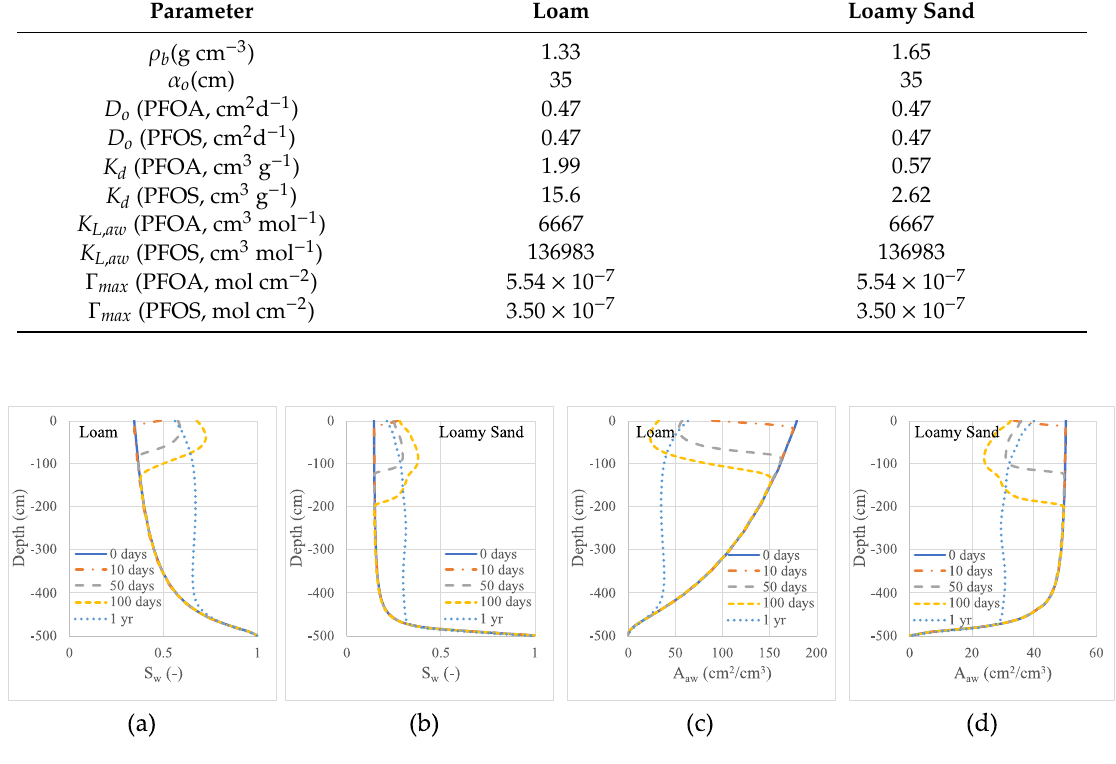
Figure 5. Illustration of the temporal changes in soil moisture and air-water interfacial area during the application of the modified HYDRUS simulator: ( a ) change in S w with depth for the loam; ( b ) change in S w with depth for the loamy sand; ( c ) change in A aw with depth for the loam; ( d ) change in A aw with depth for the loamy sand.